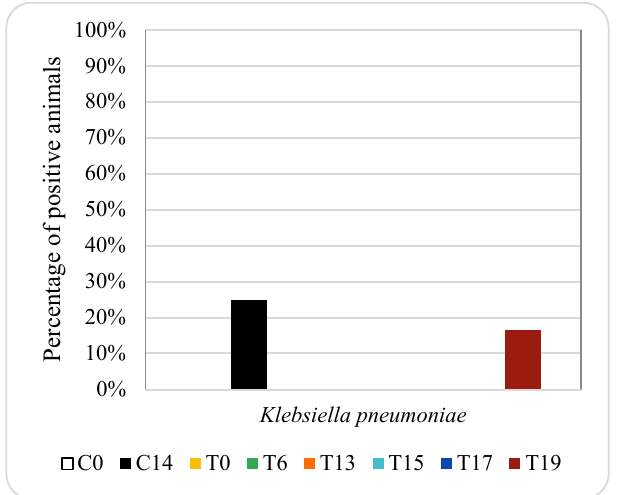
Figure 7. Effect of oxytetracycline treatment on ESBL-producing K. pneumoniae in pig genital samples. For group descriptions, C0, C14, T0, T6, T13, T15, T17 and T19: see Table 1.